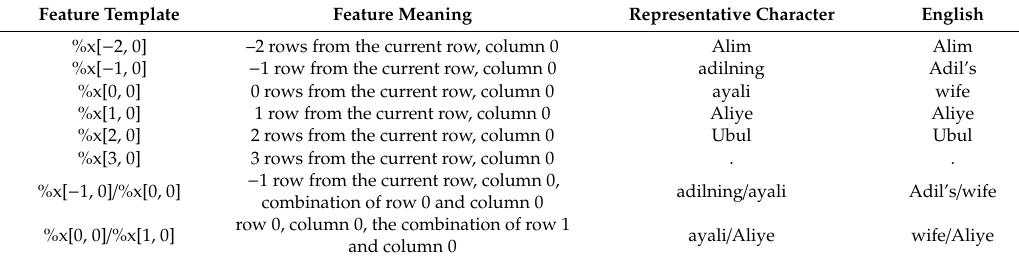
Table 4. Feature template table for example words.